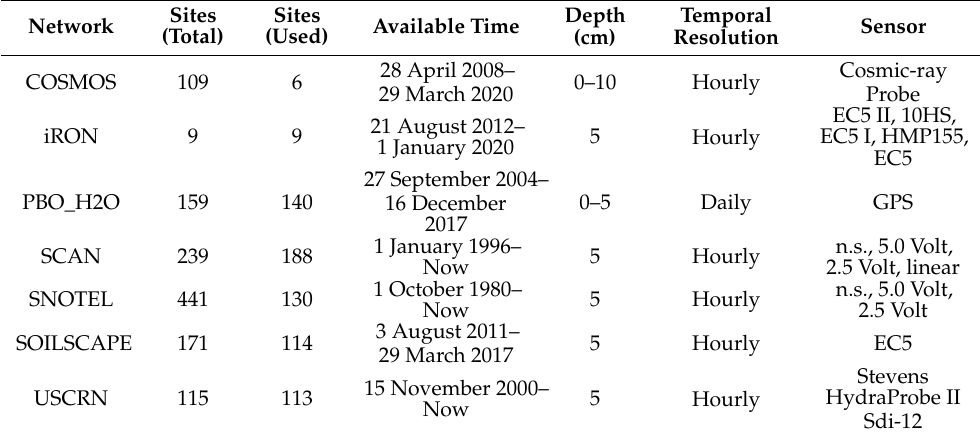
Table 1. The characteristics of the in-situ